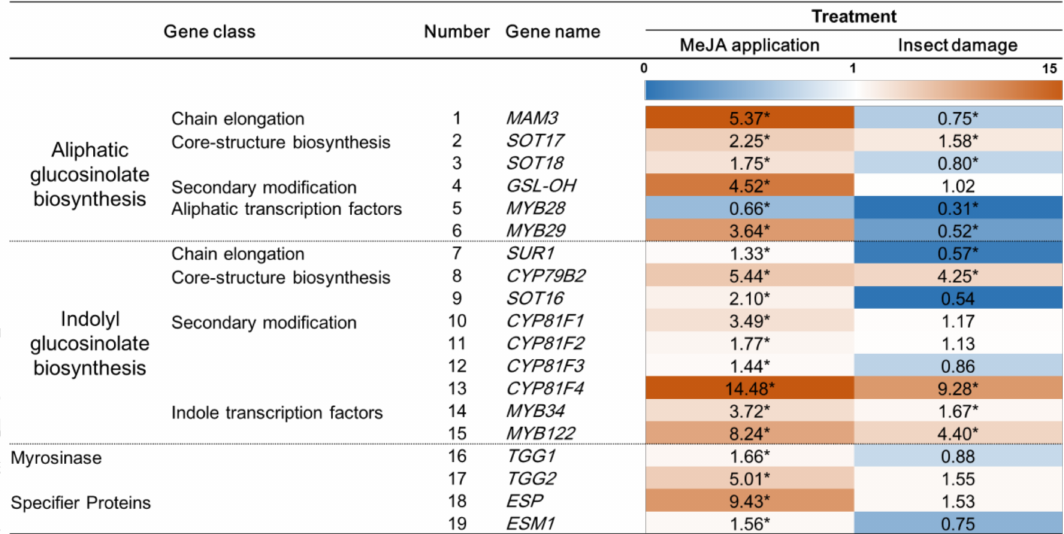
Figure 1. Expression of known genes involved in the GS biosynthesis pathway, myrosinase biosynthesis, and related to specifier proteins associated with GS hydrolysis in extracts of “Red Russian” kale plants 4 days after treatment with 250 µ M MeJA or insect damage. Asterisk indicates a significant difference compared to the control using student t -test ( p < 0.05). The values highlighted in red and in blue indicate significantly upregulated or downregulated,